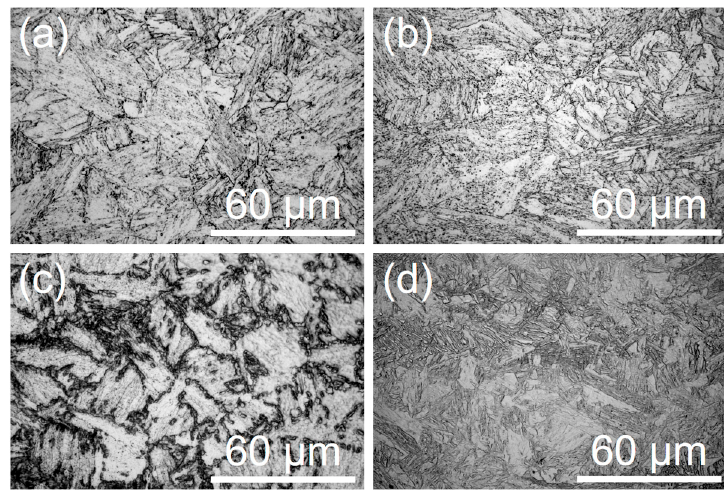
Figure 2. Optical metallography images showing the as-quenched microstructure in S690Q steel after tempering at ( a ) 600 °C, ( b ) 660 °C, ( c ) 720 °C, and ( d ) 780 °C for 1 h.